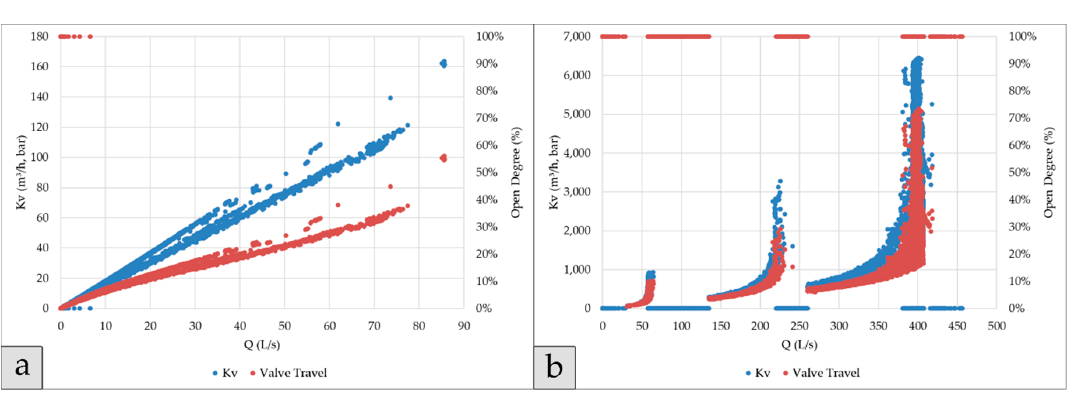
Figure 10. ( a ) PATs installation scheme for point #7. ( b ) Theoretical recovery energy for each scenario. ( c ) Energy recovered by PAT. ( d ) Energy distribution by month.